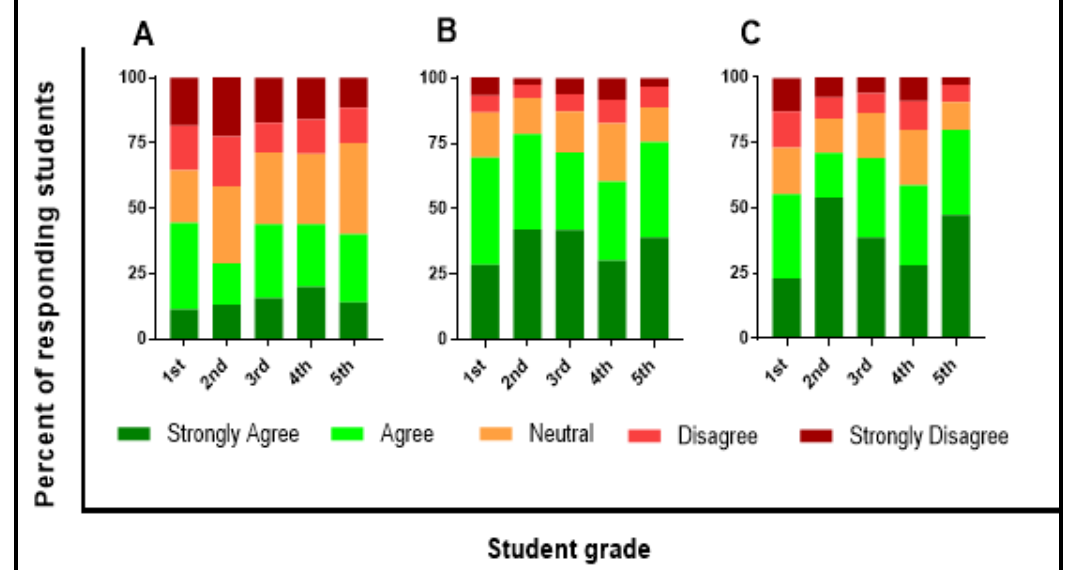
Figure 1. Student perceptions on the different modes of virtual content delivery used in the hybrid education model. A: synchronous lectures helped me understand the materials better, B: recorded